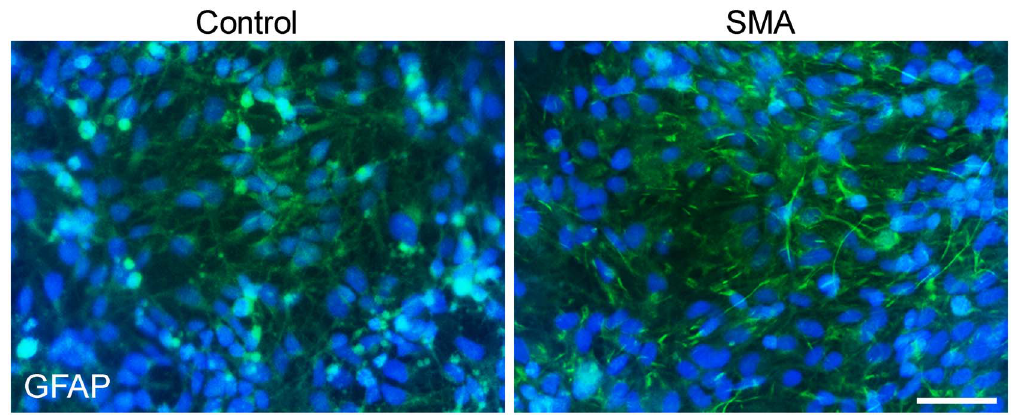
Figure 4. Peripheral glial cells are present in the sensory neuron cultures. GFAP + glial cells (green) are simultaneously generated during the sensory neuron differentiation in both control and SMA iPSC cultures. Nuclei are labeled with Hoechst nuclear dye (blue). Scale bar=50 m m.